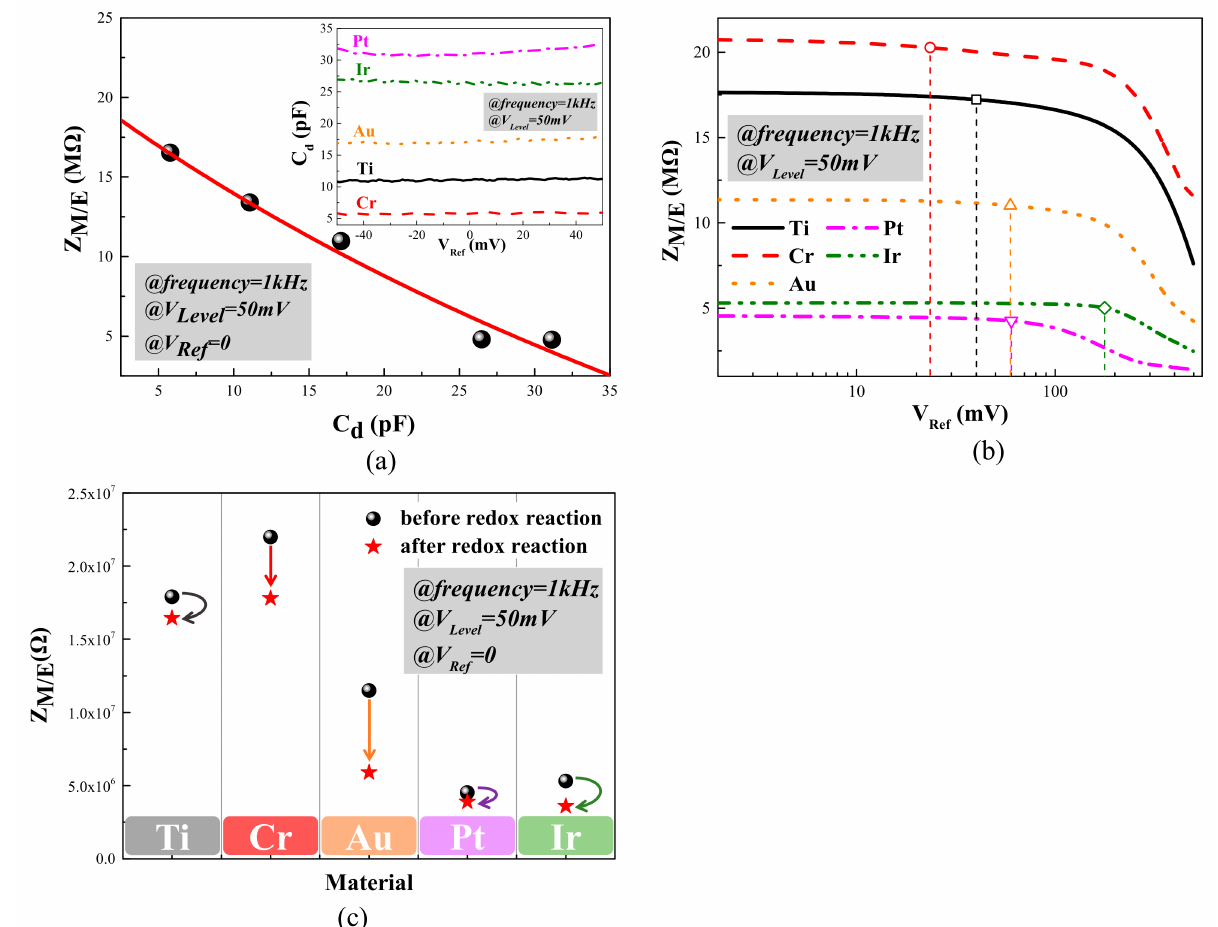
Figure 5. ( a ) Experimental values and fitting result of Z M/E versus C d (V Ref = 0 and V Level = 50 mV at 1 kHz). The insert is the C d -V Ref curve of microelectrodes with different surface materials measured within the range of − 50 to 50 mV, representing the EDL capacitor. ( b ) Z M/E -V Ref curves of microelectrodes with different surface materials measured within the range of 0 to 500 mV, characterizing the critical values and electrical stability of faradaic processes. ( c ) Z M/E values of microelectrodes with different surface materials measured before and after the faradaic processes (V Ref = 0 and V Level = 50 mV at 1